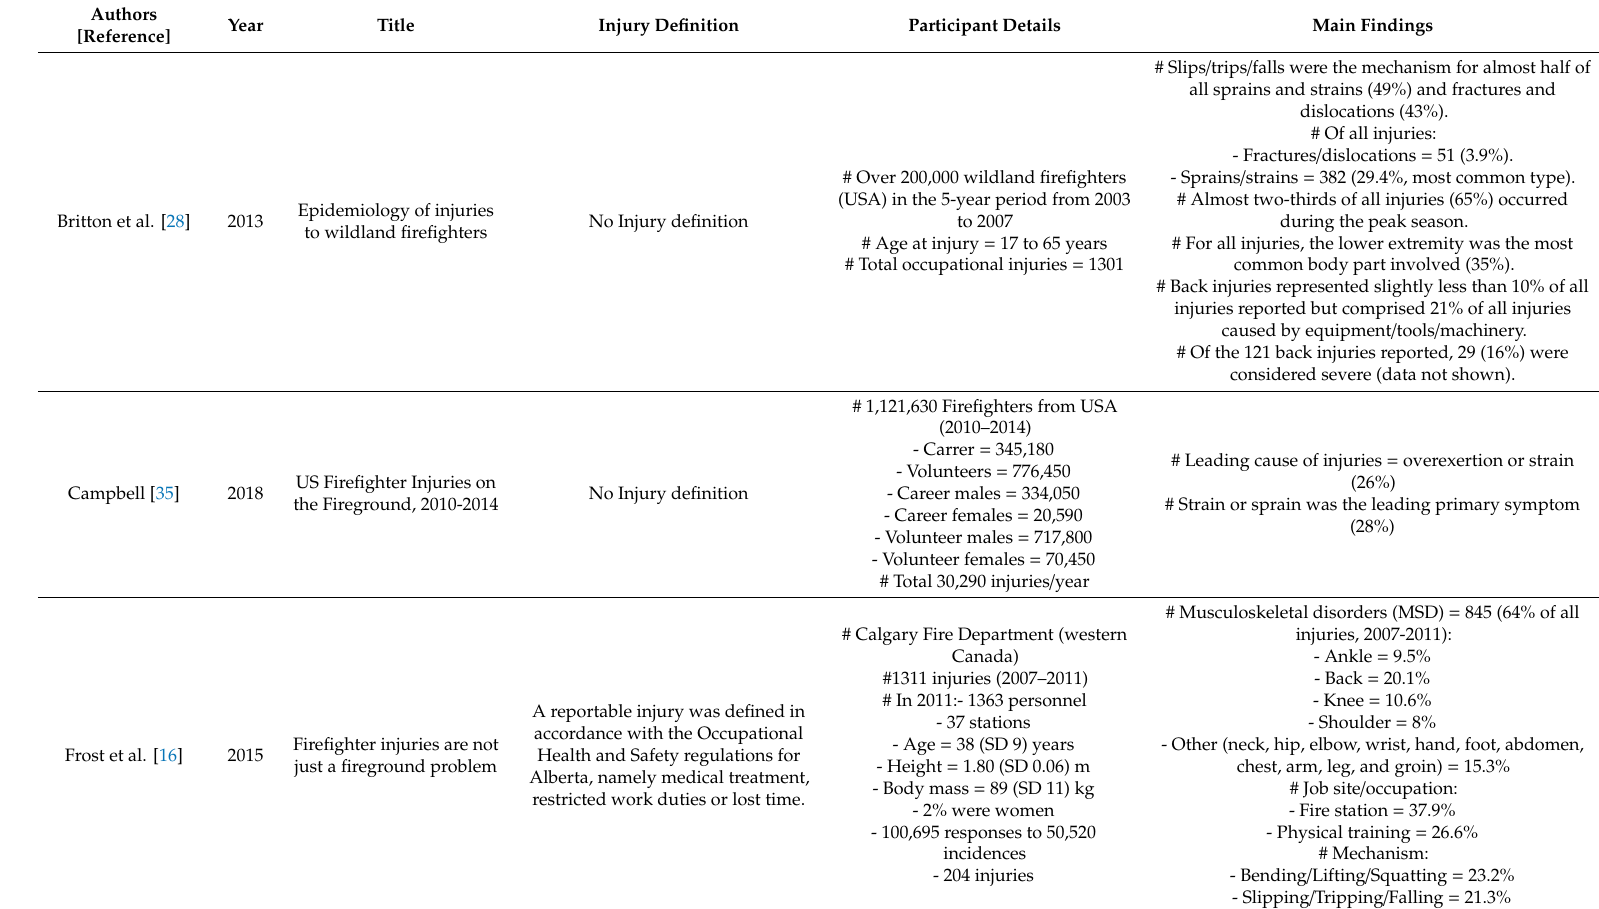
Table 5. Injury definitions, participants and main findings from each included